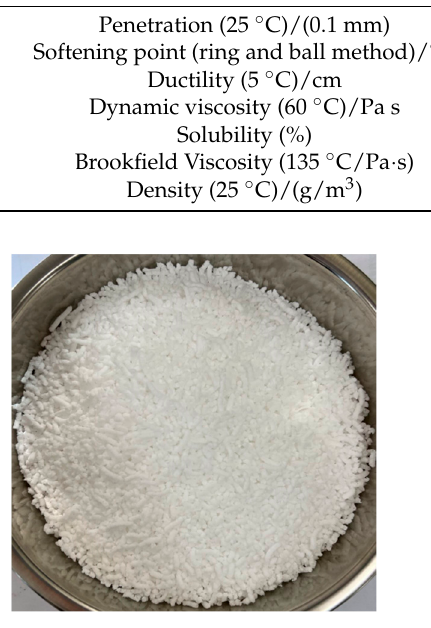
Figure 2. SBSYH-792E modifier.